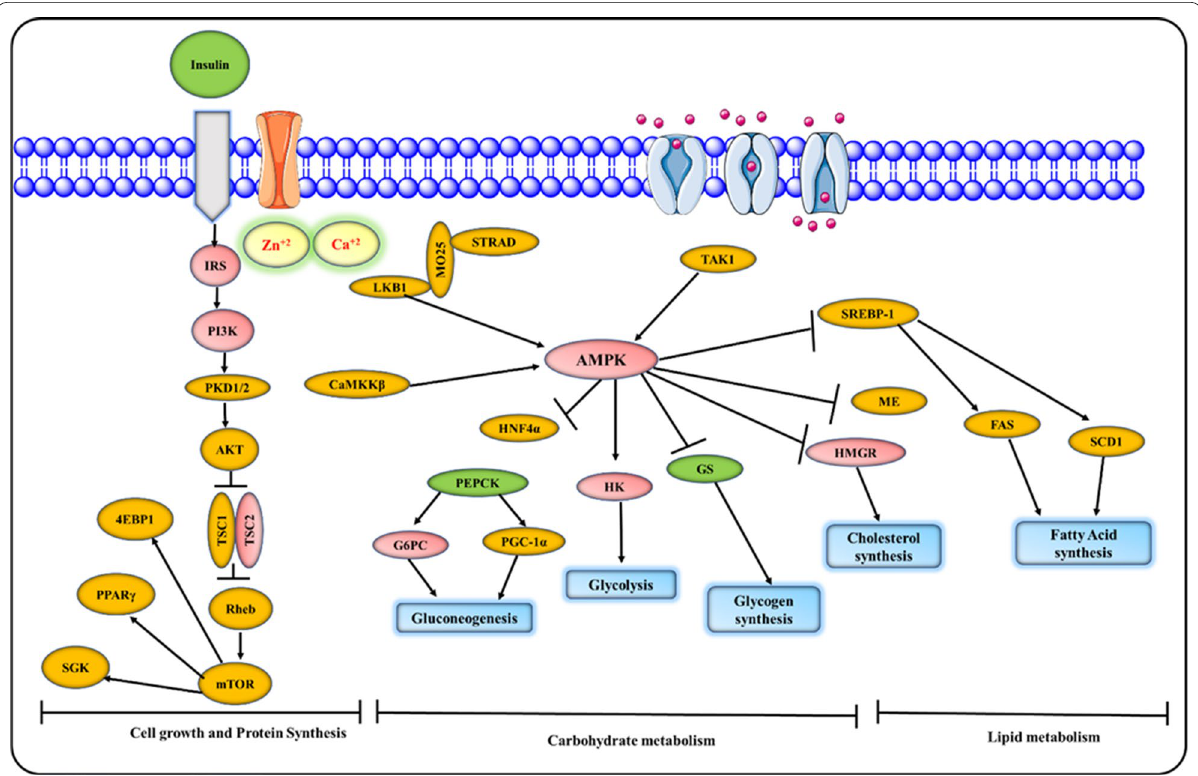
Fig. 15 Mechanism of action of extracts through AMPK activation results in increase in glucose uptake, inhibition of gluconeogenesis and fatty acid synthesis. Phosphoenolpyruvate carboxykinase AMP-activated protein kinase Sterol regulatory element-binding